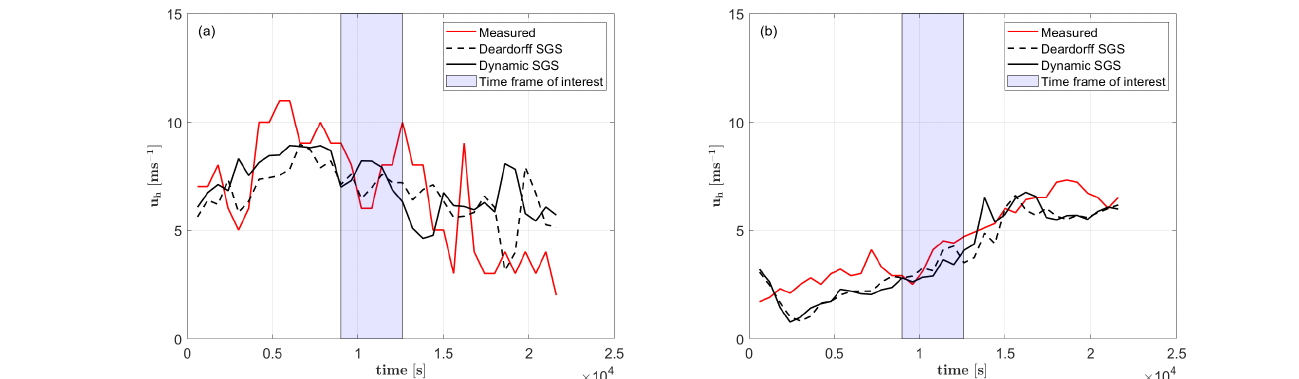
Figure 11. Temporal evolutions of 10 min time-averaged horizontal wind speed u h at ( a ) weather station Piz Corvatsch (COV) and ( b ) weather station Passo del Bernina BEH over 21,600 s simulation time. The red lines present the measured data. The simulated data of Dynamic SGS model and Deardorff model (dashed) are displayed in black. The box in both subfigures in light blue shading indicate the time frame of interest for the flight simulation experiment, from 9000 s to 12,600 s after the start of the simulation at 06:00 UTC.